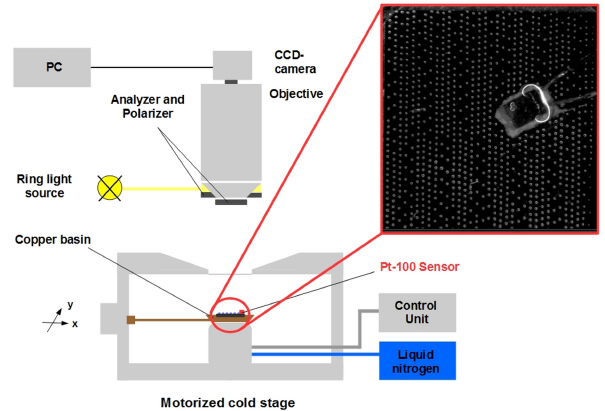
Figure 1. Schematic drawing of the nanoliter droplet freezing as- say setup (side view). The inset shows the top view of 10 × 10mm Si-wafer with ≈ 1200 droplets immersed in silicon oil. The square shape near the center of the wafer is the Pt-100 temperature